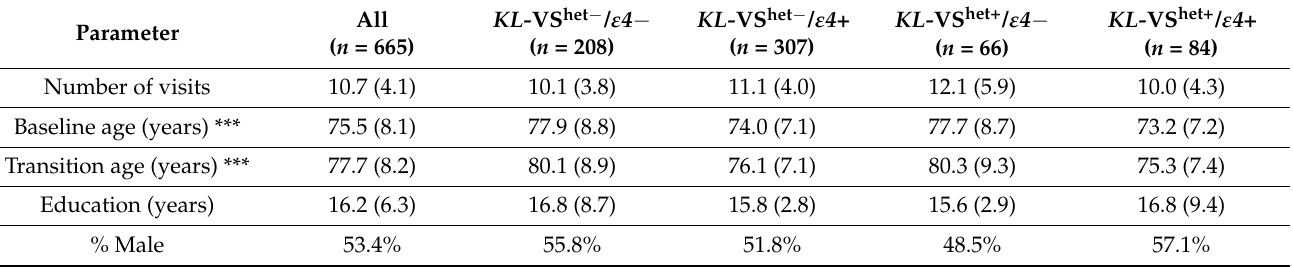
Table 1. Demographic and clinical characteristics in analyzed participants and grouped by KL-VS het and APOE ε 4